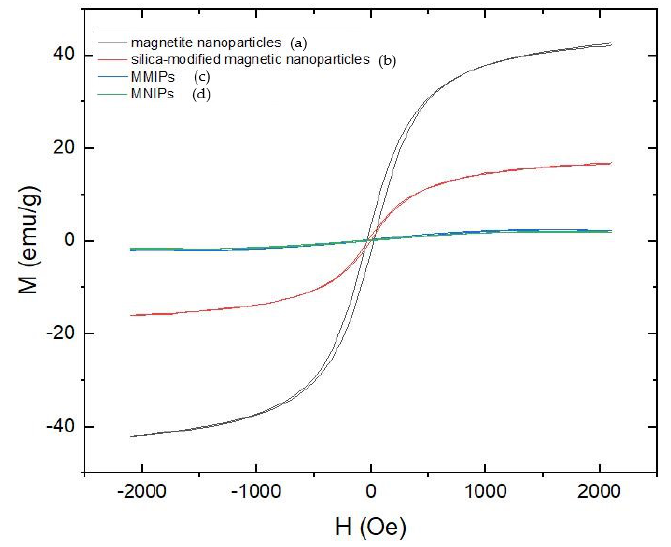
Figure 5. Hysteresis loop of the (a) synthesized magnetite nanoparticles (magnetite), (b) sili- modified magnetic nanoparticles, (c) MMIPs, and (d) ca-modified magnetic nanoparticles, (c) MMIPs, and (d) MNIPs.